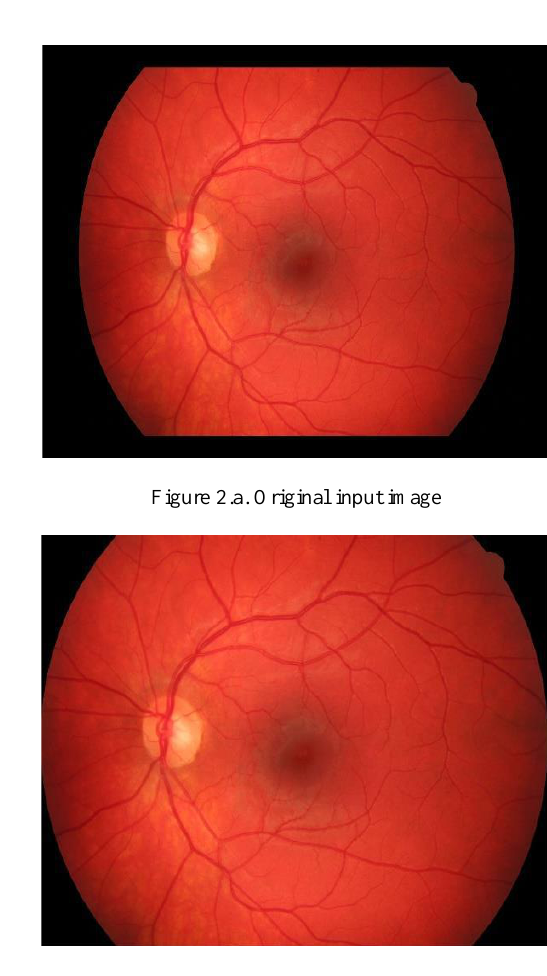
Figure 2.b. Cropped image